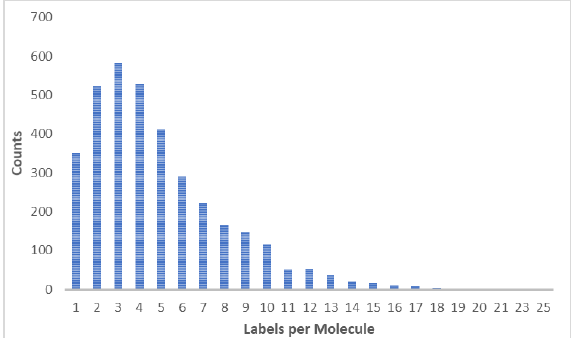
Figure 3. Number distribution of descriptors of different odor molecules.